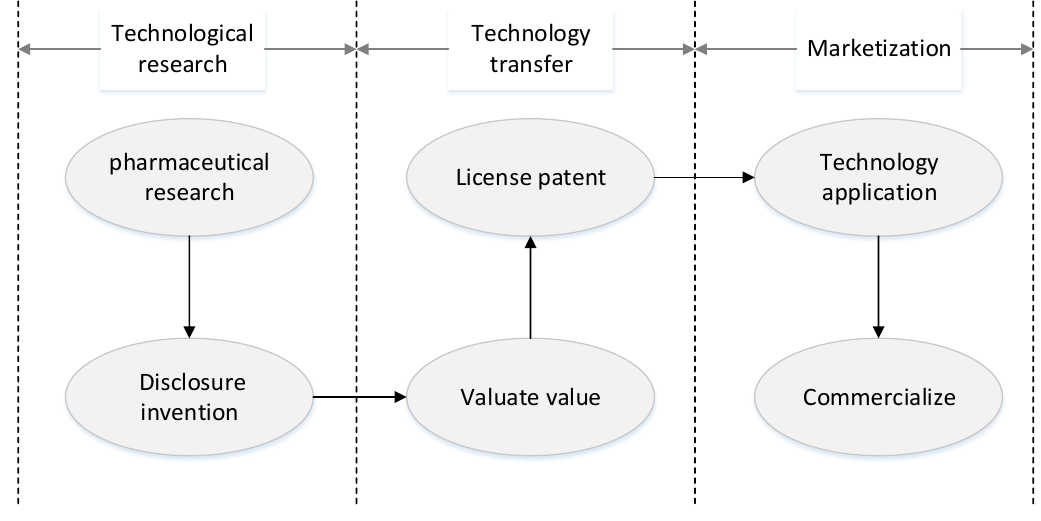
Figure 1. The process of the transfer of pharmaceutical research results.